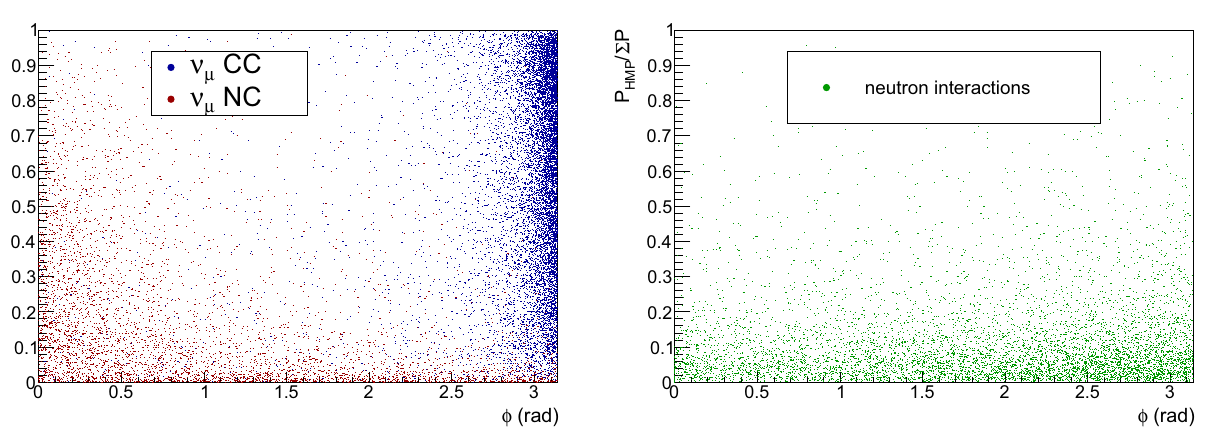
tron interactions ( E n > 100 GeV) is also shown on the